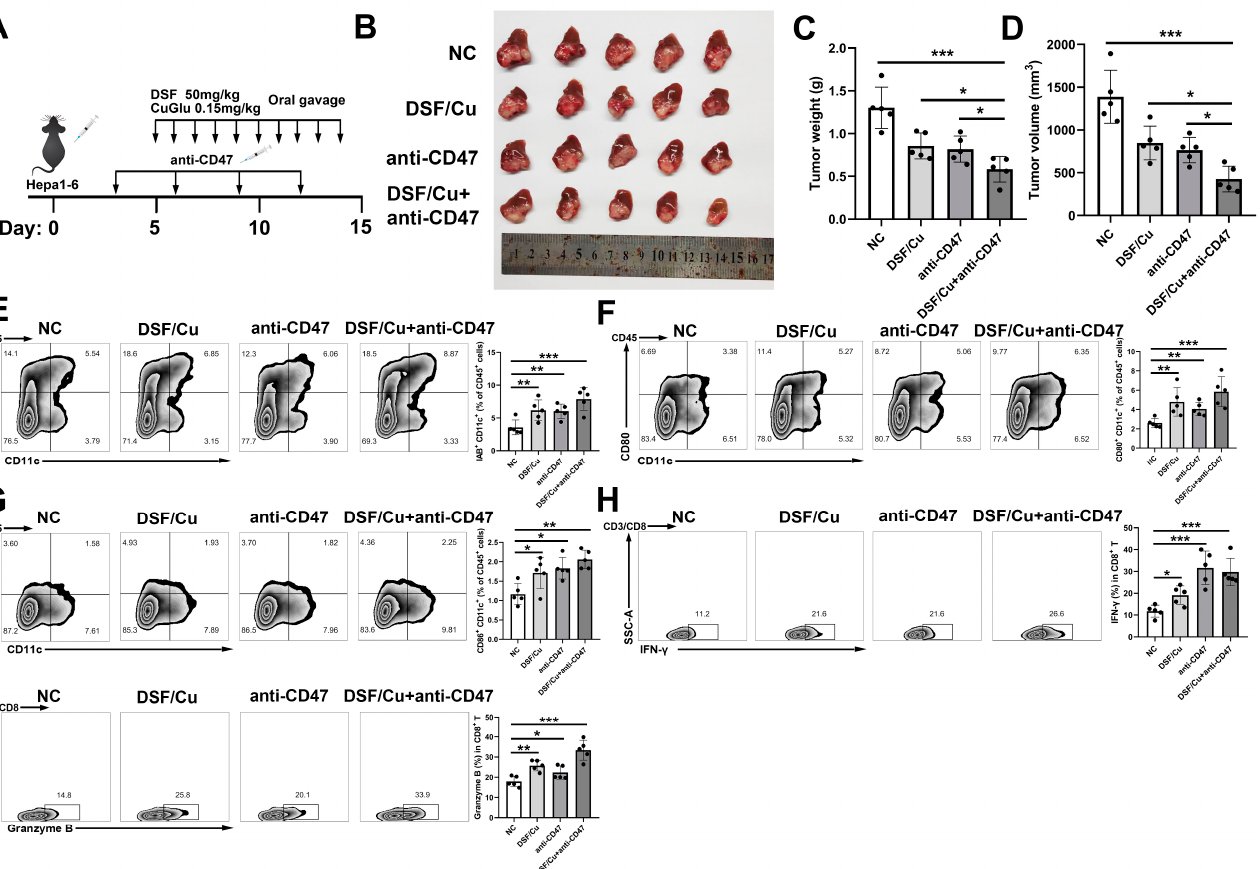
Figure 6. DSF/Cu enhances CD47 blockade activities in vivo. ( A ) A schematic view of the orthotopic tumor model for DSF/Cu and anti-CD47 treatment. ( B ) Tumor appearance, ( C ) weight and ( D ) volume were compared with each group (n = 5). Analysis of the percentage of ( E ) I-Ab + , ( F ) CD80 + , ( G ) CD86 + DC cells in CD45 + cells. Analysis of the percentage of IFN- γ ( H ) and Granzyme B ( I ) in CD8 + T cells. ns: p > 0.05; *: p < 0.05; **: p < 0.01; ***: p < 0.001.